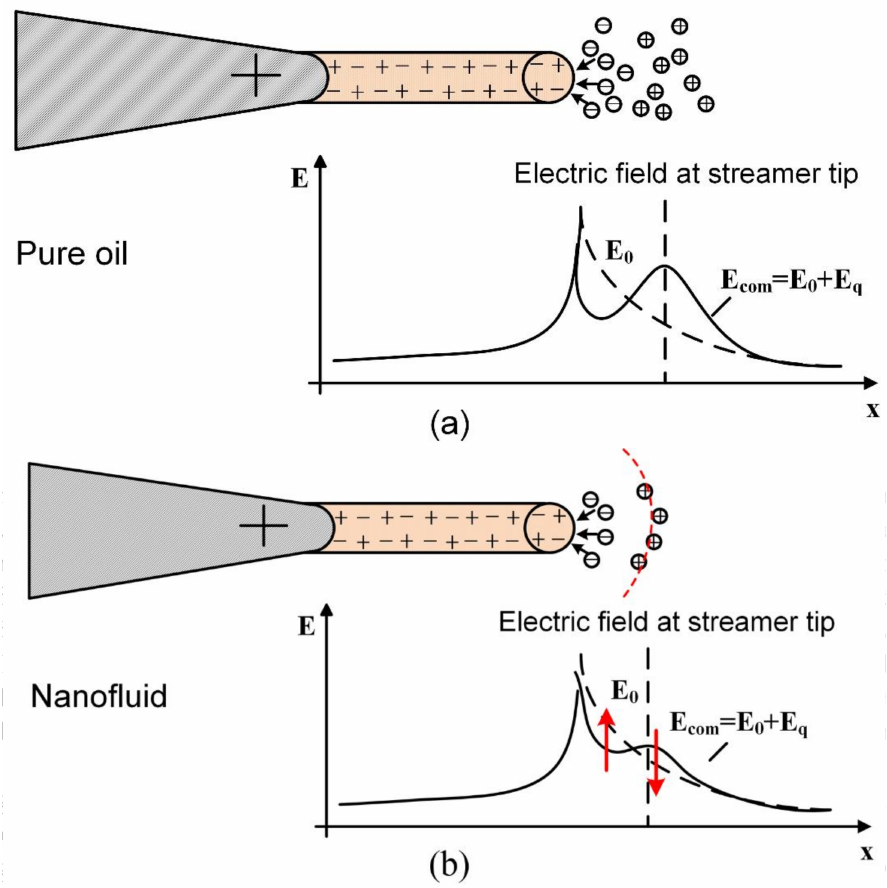
Figure 7. The electric field distribution in pure oil ( a ) and nanofluids ( b